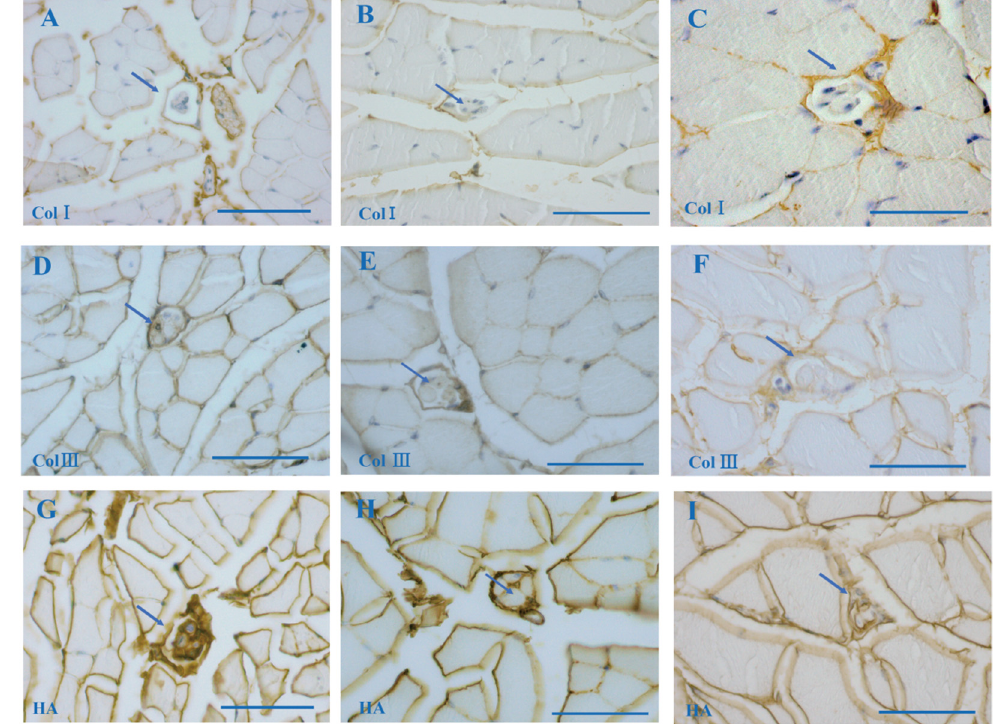
Figure 3. MS embedded in the extracellular matrix elements with immunohistochemistry staining of collagen type I (COLI) ( A – C ), collagen type III (COLIII) ( D – F ), and biotinylated HABP ( G – I ). The COLI and COLIII localized in the MS capsule. The HABP localized in the MS. ( A , D , G ): A MS in the hindlimb of a 6 week-old mouse (Group A); ( B , E , H ): a MS in the hindlimb of an 8-month-old mouse (Group B); ( C , F , I ): a MS of the hindlimb of a 2-year-old mouse (Group C). Scale bar: 50 μ m.